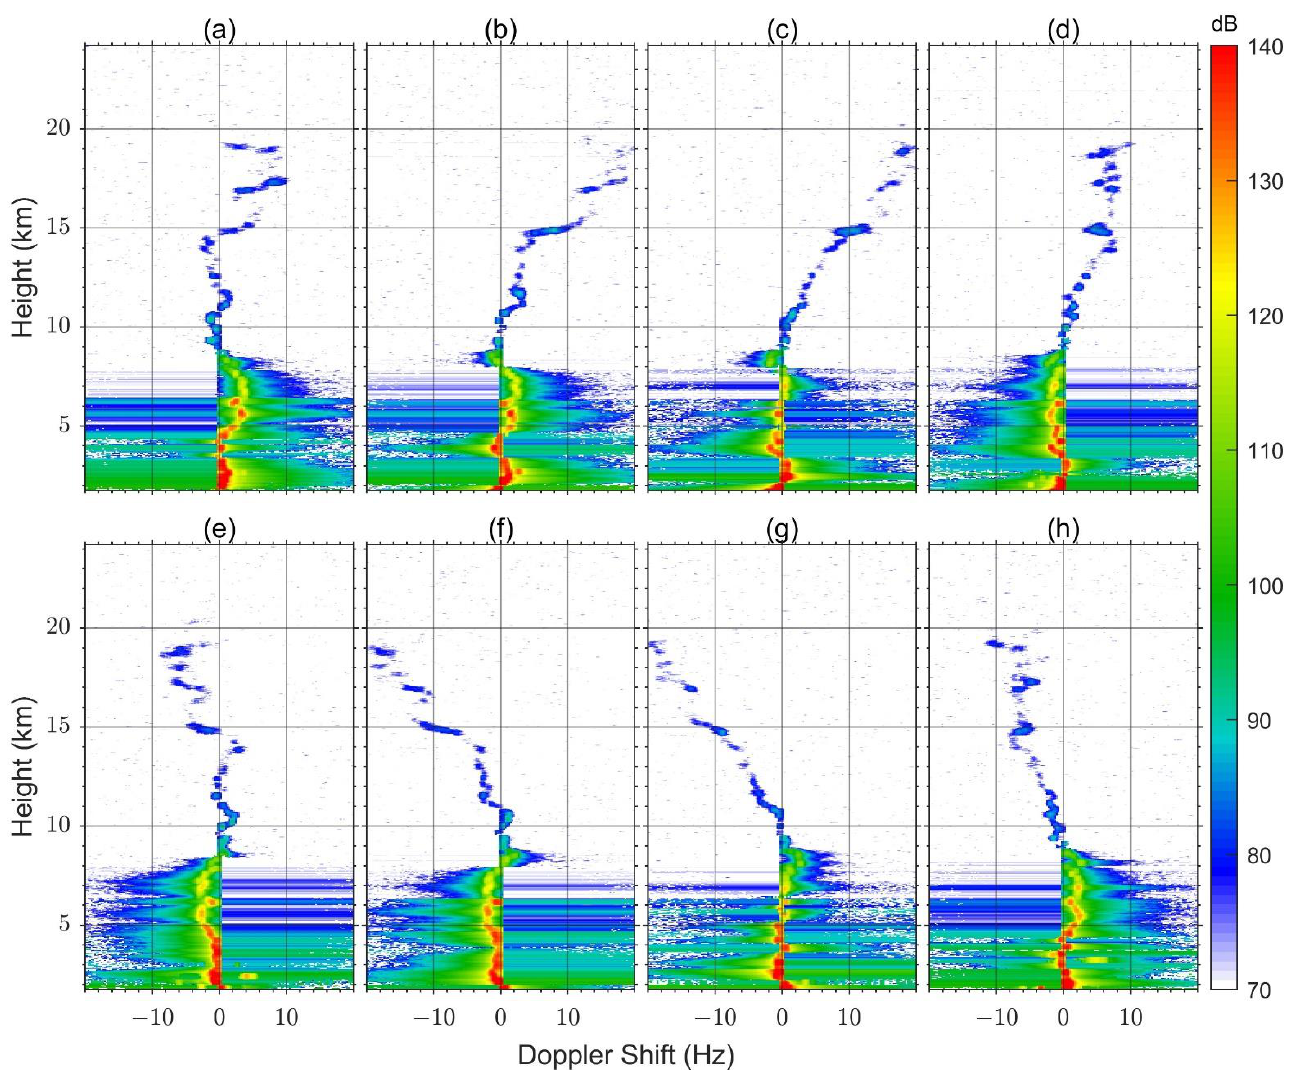
Figure 2. Echo power spectrum corresponding to the eight azimuths of 0° (( a ) north), 45° (( b ) northeast), 90° (( c ) east), 135° (( d ) southeast), 180° (( e ) south), 225° (( f ) southwest), 270° (( g ) west), and 315° (( h ) northwest) with a zenith angle of 15°. The unit is dB, and the experiment time was 10:00 local time on 17 July 2021.